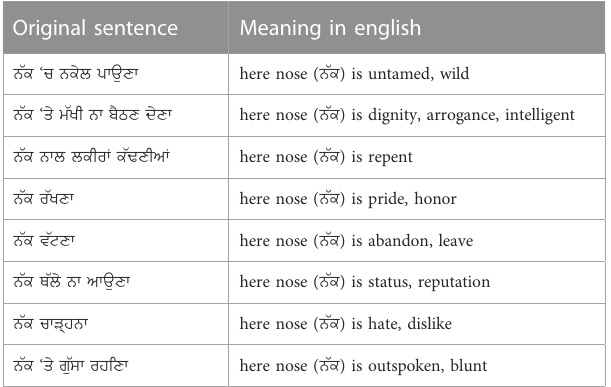
TABLE 1 A few examples of using nose as a metaphor of positivity in the Punjabi culture. Original